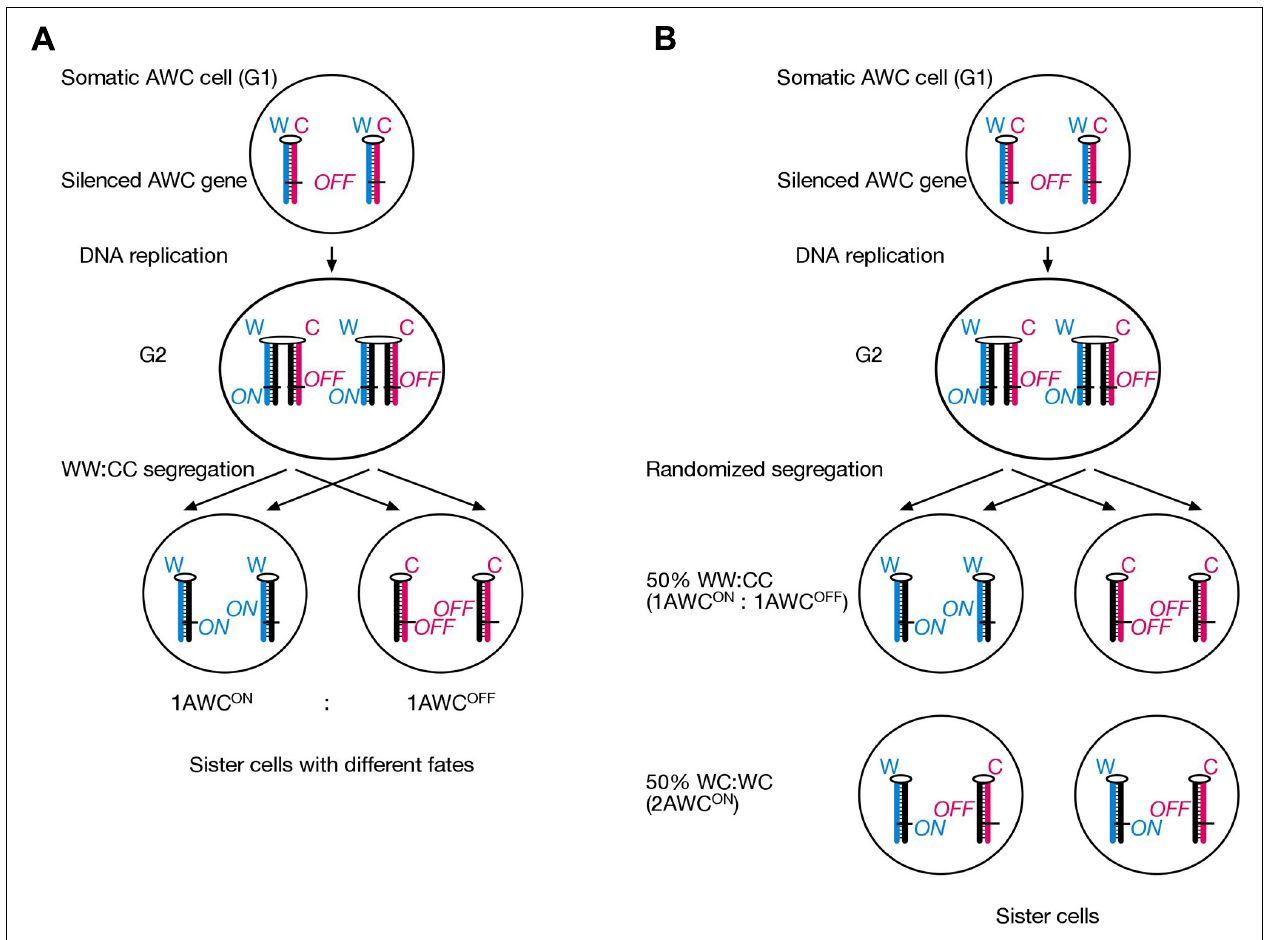
FIGURE 4 |A finding published by Dr. Michael Levin’s laboratory is interpreted to suggest that an SSIS-like mechanism operates during olfactory neuron asymmetry development in C. elegans . (A) An AWC precursor cell undergoes asymmetric cell division and selectively segregates epigenetically differentiated sister chromatids containing an AWC master-regulator gene in aWW:CC fashion, such that always a